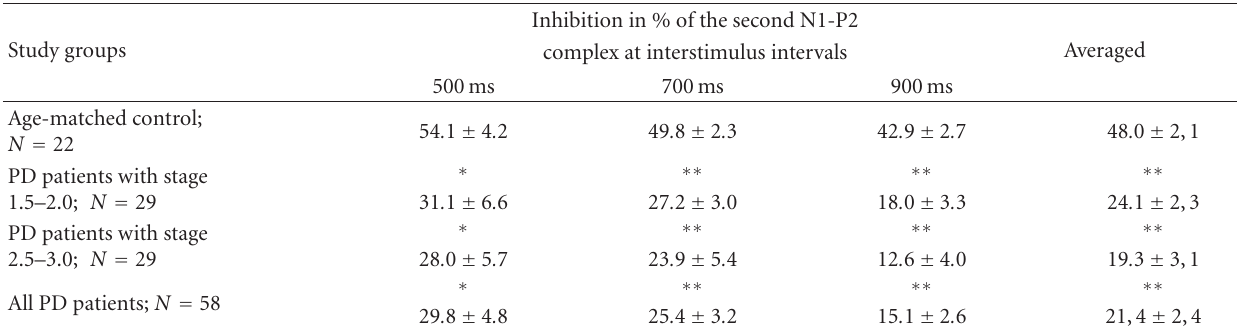
Table 2: Inhibition of the second N1-P2 complex of cortical auditory evoked potentials at paired-click stimulation in age-matched control group and patients with Parkinson’s disease (Mean ± SE).